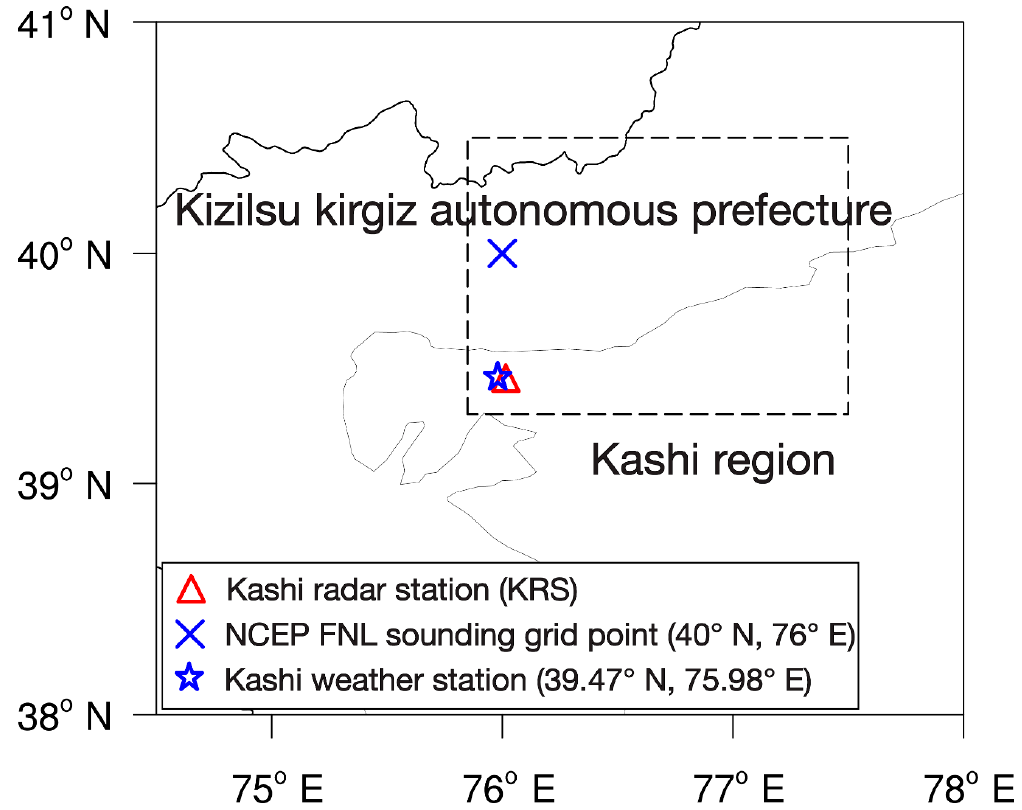
Figure 1. Study area where the severe convective weather occurred. It is located in the innermost domain (d04) in Figure 5. The solid black and gray lines indicate the national and district boundaries, respectively. Dashed rectangle area indicates the area analyzed in Figures 4, 6 and 8.